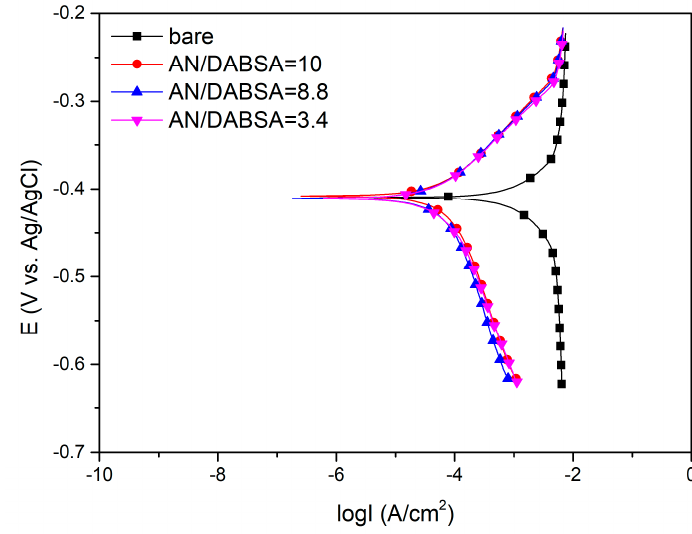
Figure 10. Polarization curves of bare and SPAN-deposited mild steels with different AN/DABSA ratios in 1 M HCl. Table 2. Electrochemical parameters obtained using polarization on bare and SPAN-deposited mild steels with different AN/DABSA ratios in 1 M HCl.